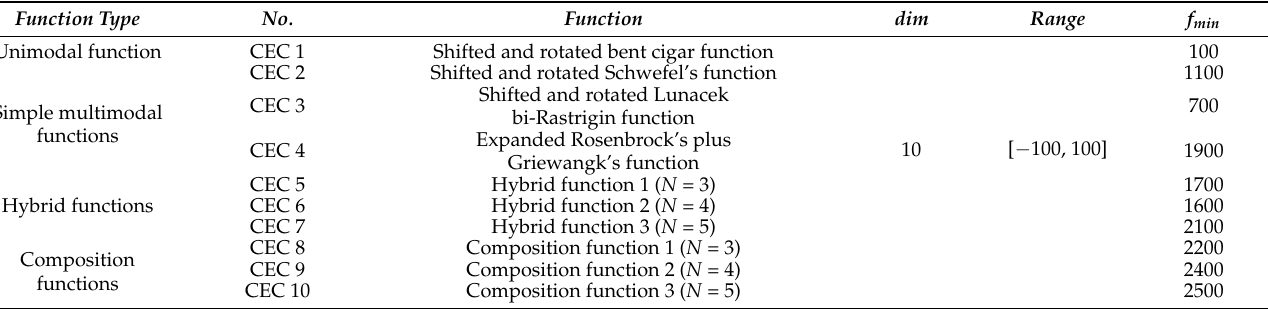
Table 5. Details of CEC2020 benchmark functions.